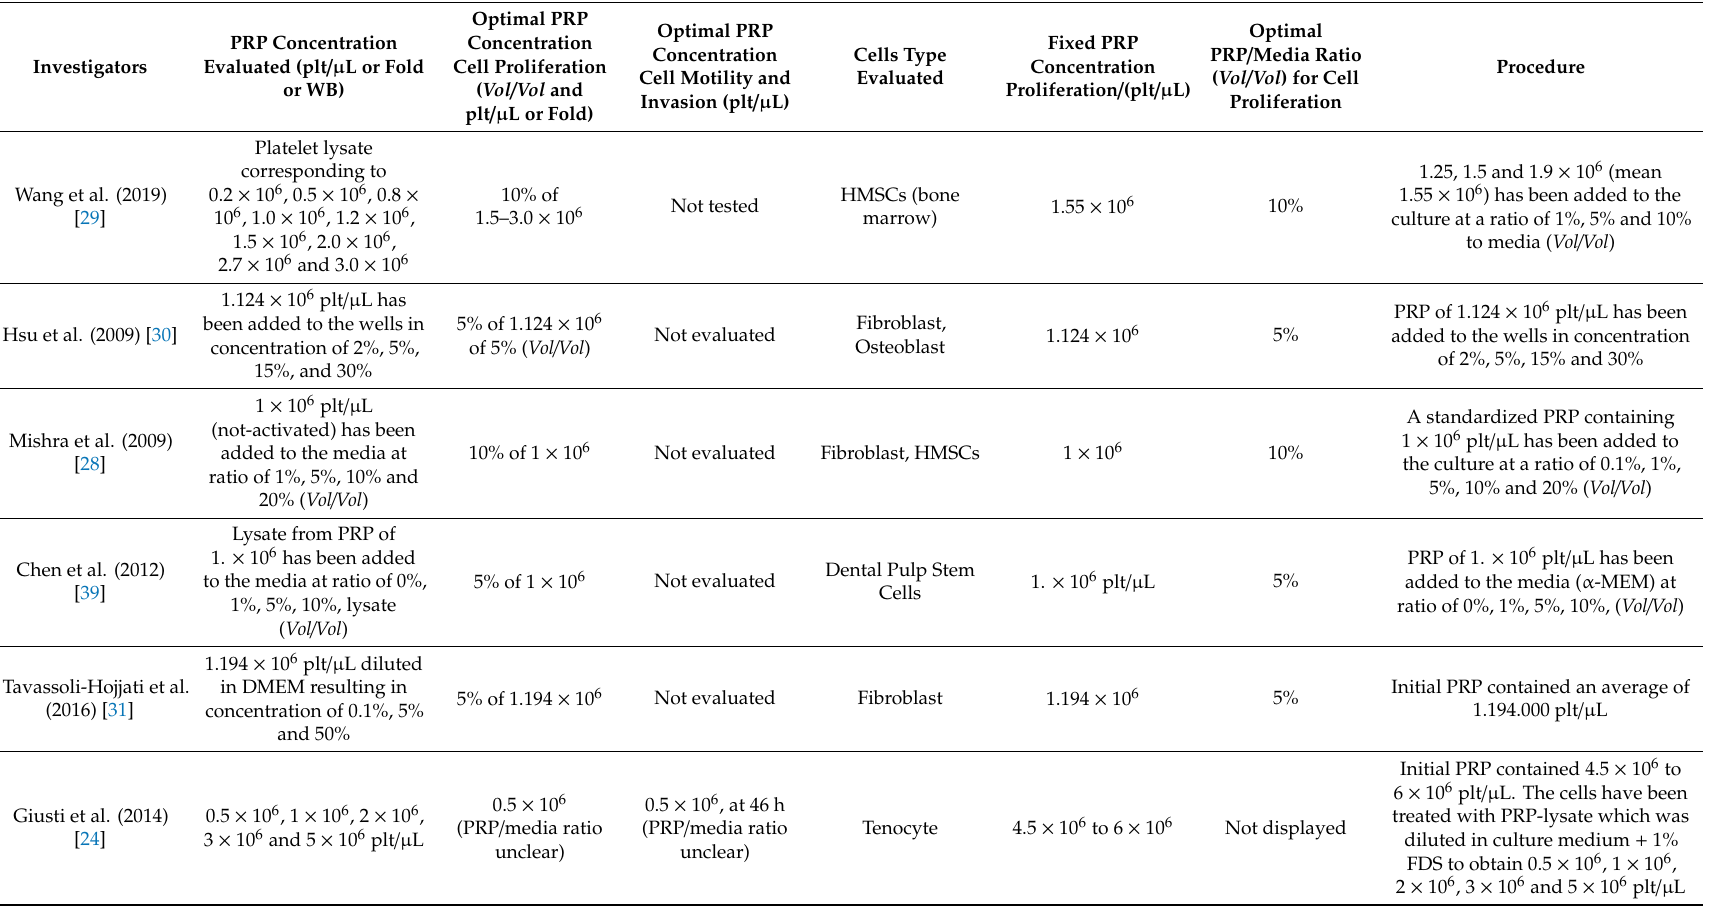
Table 1. Synthetic analysis of the outcomes: platelet-rich plasma (PRP) concentration (plt / µ L) and PRP Volume ( Vol / Vol